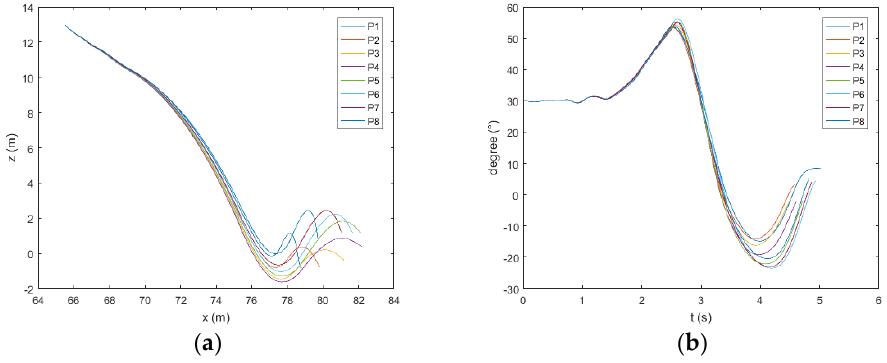
J. Mar. Sci. Eng. 2020 , 8 , x FOR PEER REVIEW Figure 20. Trajectory ( a ) and pitch ( b ) of the lifeboat freefall when the wave height is 2 m.